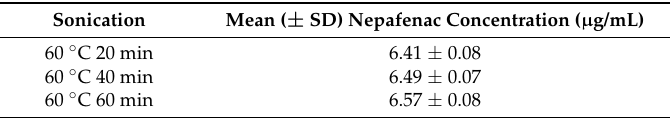
Table 2. Nepafenac concentrations in aqueous solution containing 1% w / v γ CD after heating by sonication. Results are expressed as mean ± SD (n = 3).